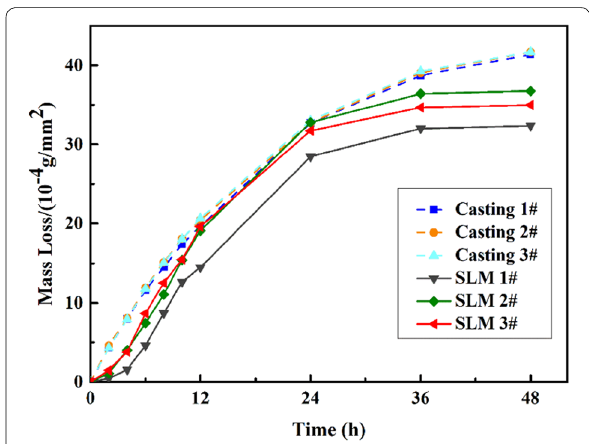
Figure 7 Mass loss curves of the S136 samples fabricated by SLM and casting in 6% FeCl